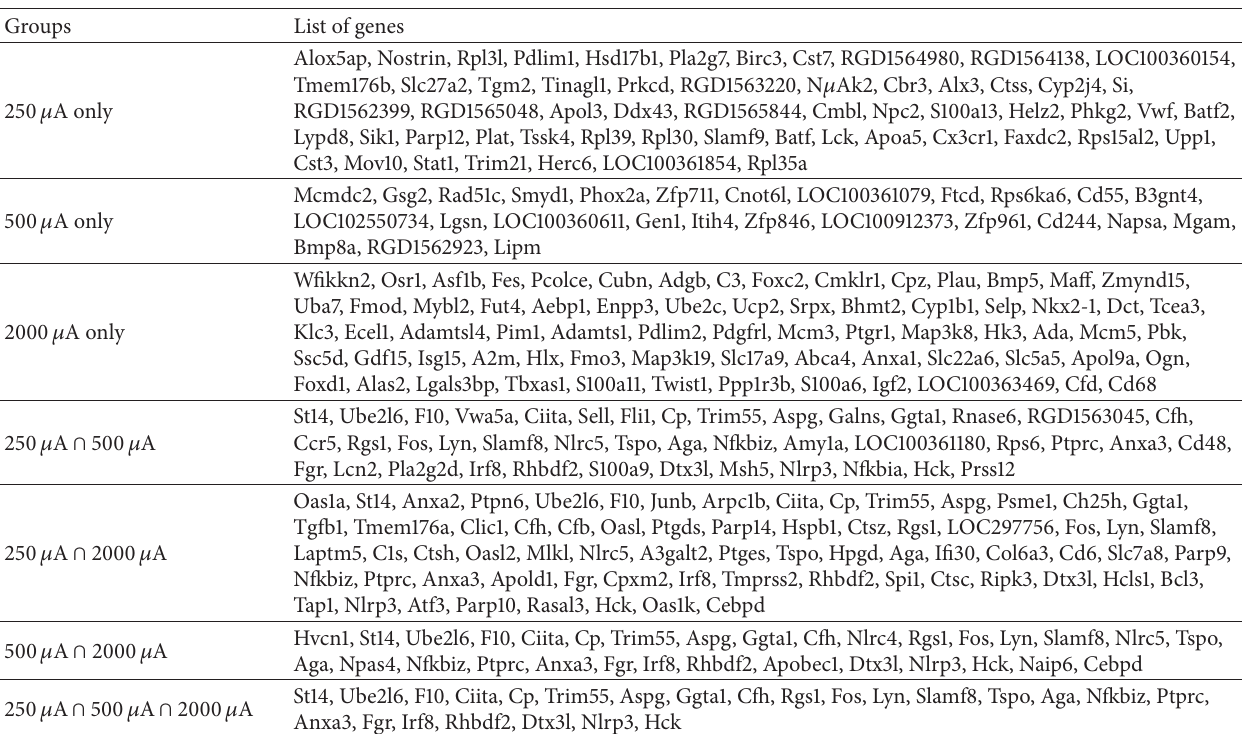
Table 2: Genes in the primary metabolic process subcategory that were detected from RNA-Seq data